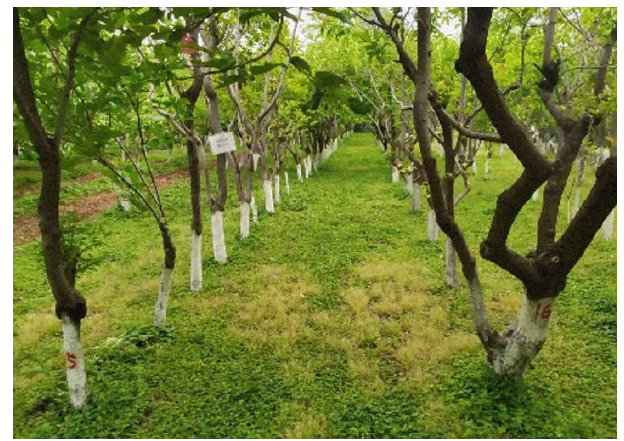
Figure 14. Traditional orchard environment.